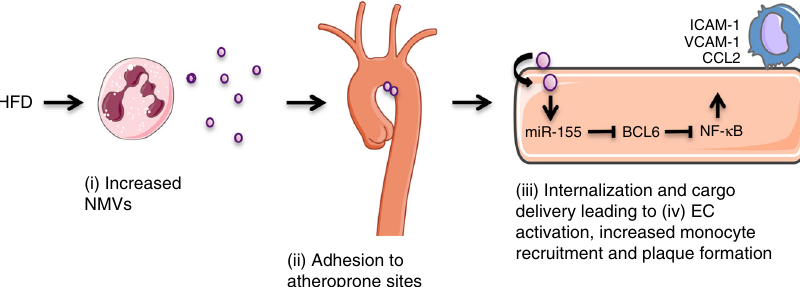
Fig. 10 Proposed model of the molecular mechanism of action of NMVs in atherosclerosis. High fat diet increases the level of circulating NMVs (i) that preferentially adhere to atheroprone regions of arteries (ii) where they become internalised by endothelial cells (iii). Delivery of miR-155 to the endothelial cells downregulates BCL6, leading to an increase in NF- κ B expression and subsequent in fl ammatory activation. This results in an increase in the number of monocytes recruited to the vessel wall and enhanced atherosclerotic plaque